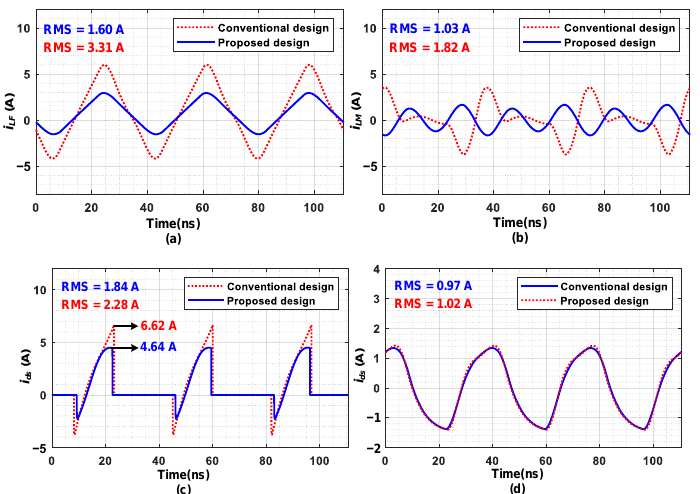
Figure 10. Waveforms of i LF ( t ), i LM ( t ), i ds ( t ) and i LS ( t ) with different design methods. ( a ) Waveforms of i LF ( t ); ( b ) waveforms of i LM ( t ); ( c ) waveforms of i ds ( t ); ( d ) waveforms of i LS ( t